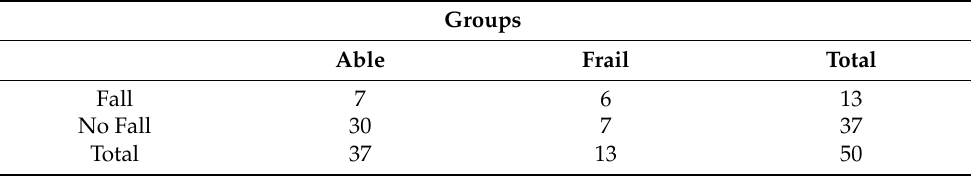
Table 2. Contingency table of subjects included in the study.